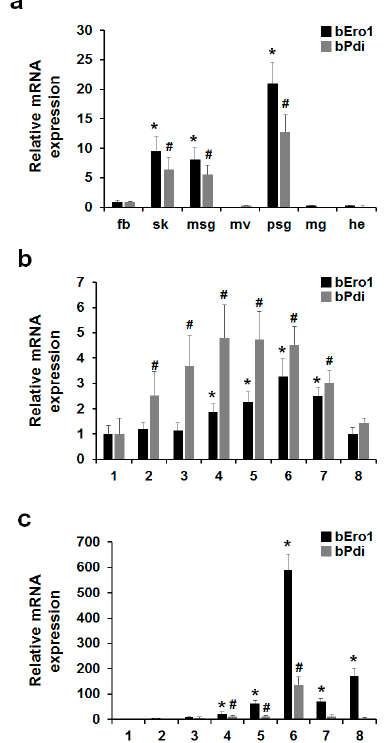
Figure 4. Expression levels of bEro1 coincide with bPdi in B. mori . ( a ) Expression levels of bEro1 and bPdi in fat body (fb), skin (sk), middle silk grand (msg), malpighian vessels (mv), posterial silk grand (psg), midgut (mg), and head (he) in three-day-old 5th instar larvae. Relative expression levels are presented as the mean ± SD ( n = 6); * p < 0.05 versus bEro1 of fat body. # p < 0.05 versus bPdi of fat body; ( b ) Expression levels of bEro1 and bPdi in developmental stages of 5th instar whole body (1–8 days). Relative expression levels are presented as the mean ± SD ( n = 6); * p < 0.05 versus bEro1 on day one. # p < 0.05 versus bPdi on day one; ( c ) Expression levels of bEro1 and bPdi in developmental stages of 5th instar posterial silk grand (1–8 days). Relative expression levels are presented as the mean ± SD ( n = 6); * p < 0.05 versus bEro1 on day one. # p < 0.05 versus bPdi on day one.